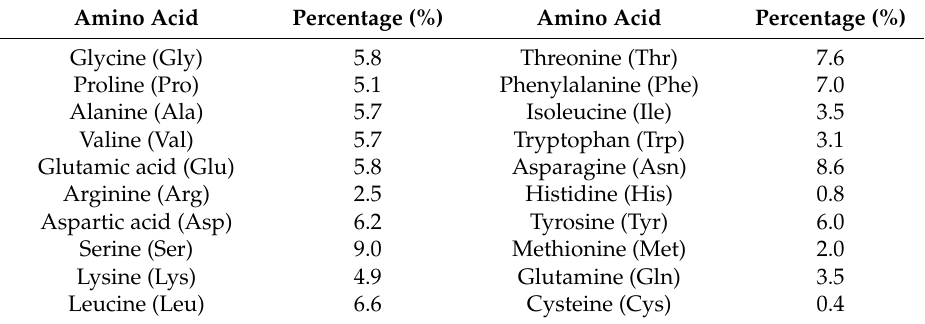
Figure 4. Molecular model of invertase from Saccharomyces cerevisiae [https: 4EQV]. Table 2. Amino acid composition of one polypeptide chain of invertase from Saccharomyces cerevisiae